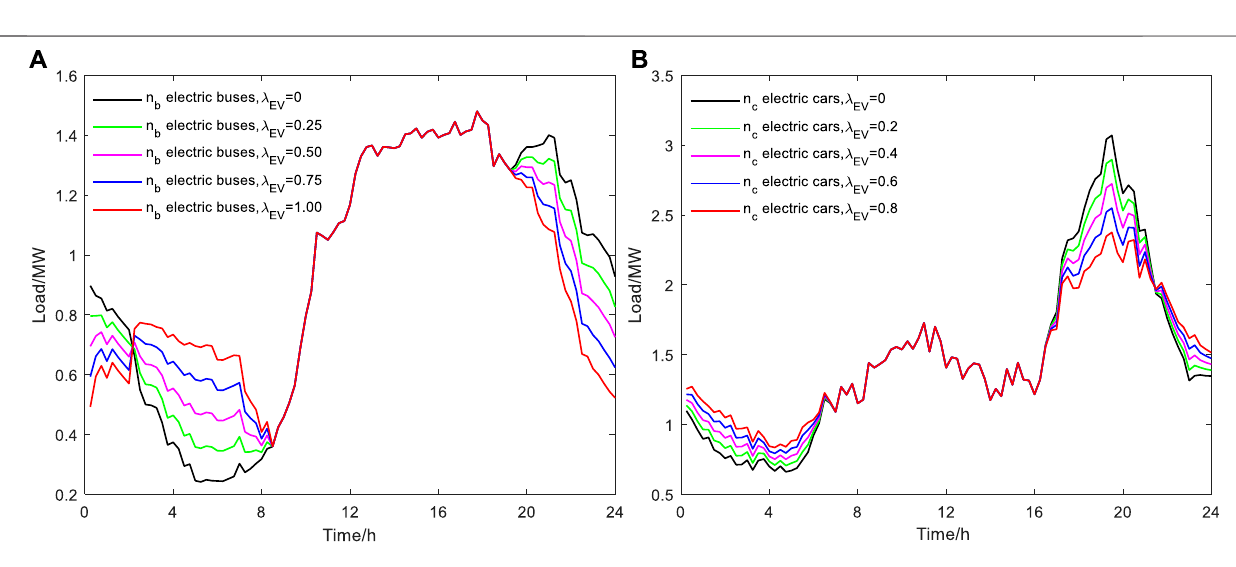
FIGURE 8 | Disorderly charging load of different load transfer rates of EVs. (A) Electric buses. (B) Electric cars.